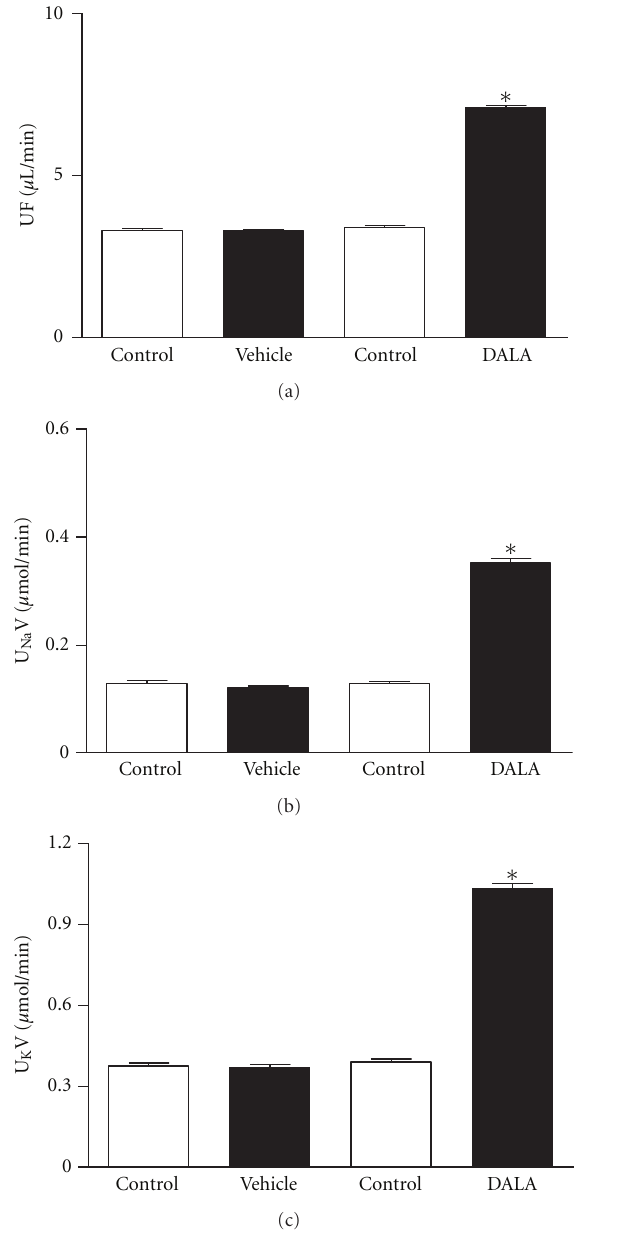
Figure 3: In anesthetized rats, DALA (80 μ mol/kg) IV infusion acutely increased urine flow and sodium and potassium excretion in untreated rats. Values are mean ± SE; n = 20. ∗ P < 0 . 05 versus control (vehicle infusion).